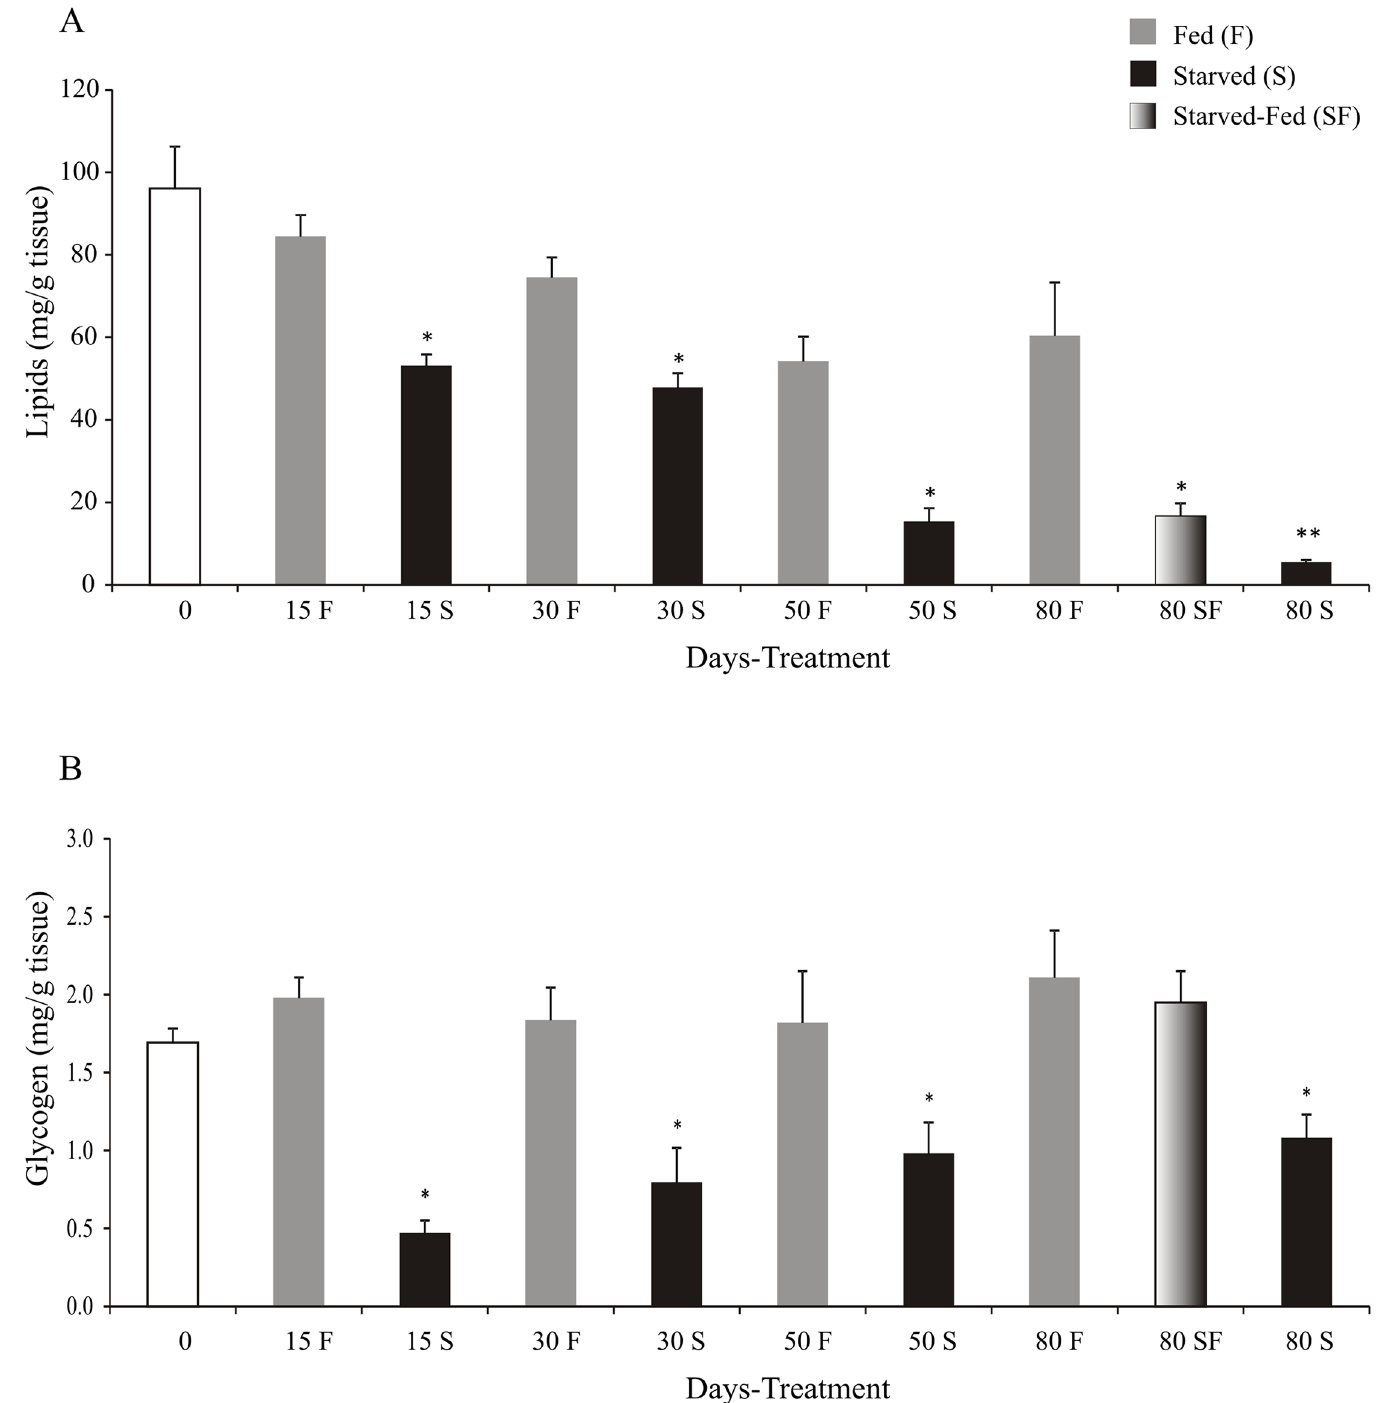
Fig 3. Lipid and glycogen levels of Cherax quadricarinatus juveniles after starvation and posterior feeding. The statistical analysis was done among treatments (F, S and SF) at each experimental time (15, 30, 50, and 80 days). * indicates statistically significant differences (p < 0.05).